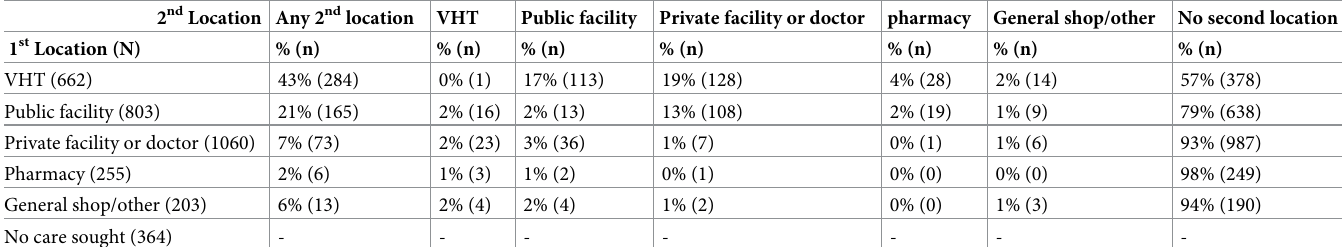
Table 4. Second care seeking choice of children with suspected malaria, diarrhoea or suspected pneumonia, by first provider visited. 2 nd Location Any 2 nd location VHT